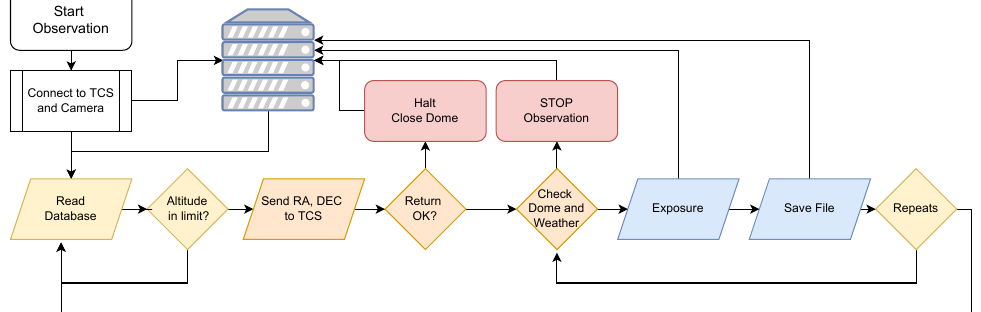
Figure 4. AST3-3 Observation Executor workflow. The workflow shows modules with different colours to explain their